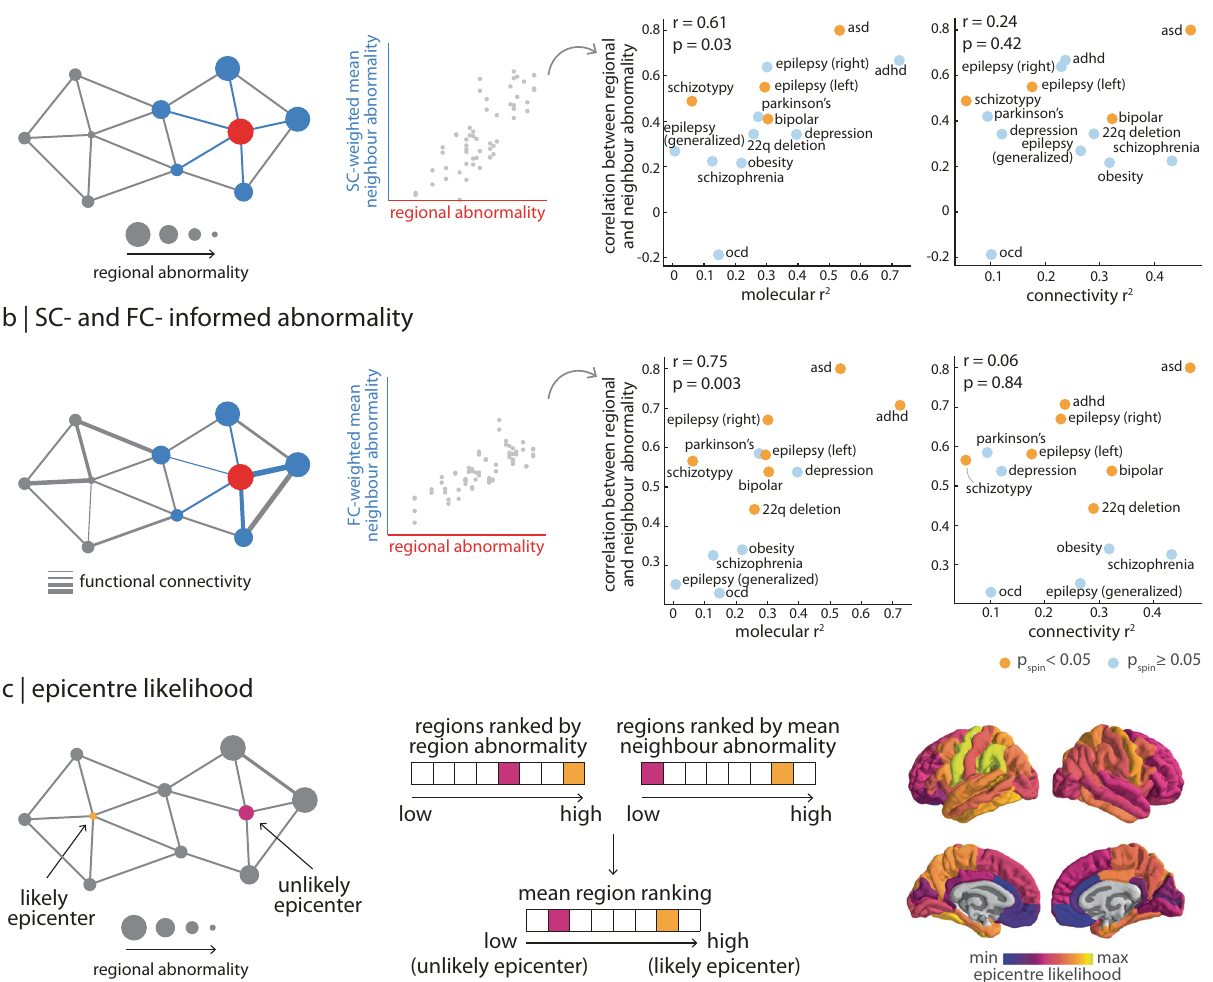
Fig. 4 | Interactions between molecular and connectomic vulnerability. a Left: schematic of structural connectivity informing disorder-related cortical changes. The correlation between SC-weighted mean neighbour abnormality and region abnormality represents the extent to which a disorder demonstrates network- spreading disorder-speci fi c corticalmorphology. Right: this correlationcoef fi cient was then correlated (Pearson ’ s r , two-sided) to both local molecular (left) and global connectivity (right) R 2 adj . Yellow points refer to disorders where the corre- lation between region abnormality and SC-weighted mean neighbour abnormality is signi fi cant ( p spin <0.05). b Left: likewise, mean neighbour abnormality can be additionally weighted by functional connectivity between regions. Right: correla- tion (Pearson ’ s r , two-sided) between the extent to which a disorder demonstrates SC- and FC-informed network-spreading cortical morphology and local molecular (left)andglobalconnectivity(right) R 2 adj .Yellowpointsrefertodisorderswherethe